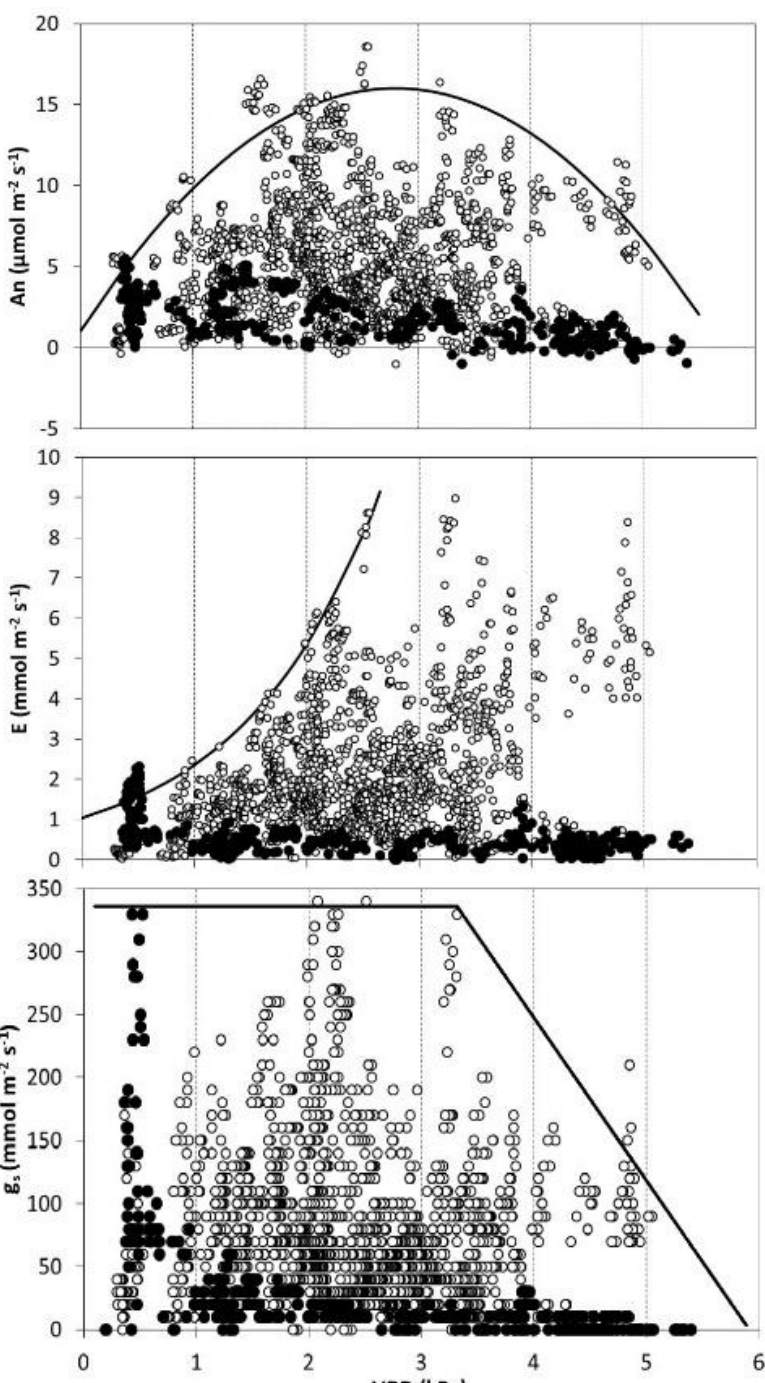
Figure 3. Regression analysis between vapor pressure deficit (VPD) and net CO 2 assimilation rates (An: Top), transpiration rates (E: middle), and stomatal conductance (g s : bottom) using boundary lines including 99 % of data points. Individual measurements were collected from March to April. Data showed in black are from the summer period. Regression for entire data set: An = − 1.91 VPD 2 + 10.7 VPD + 1.09 and E = 1.036 e 0.822 VPD .